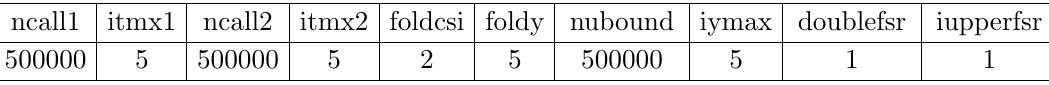
Table 1 . List of POWHEG BOX parameters set to di(cid:11)erent values than those in the manual.